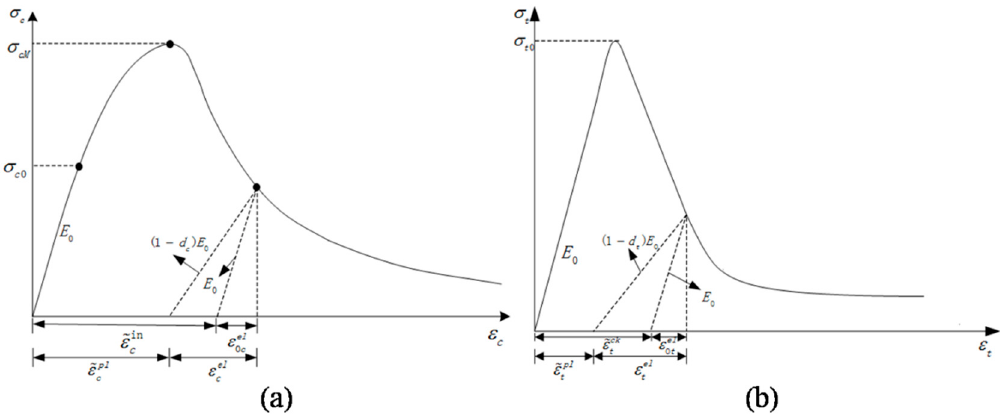
Figure 15. Illustration of uniaxial: ( a ) Compressive and ( b ) tensile response defined by CDP model.